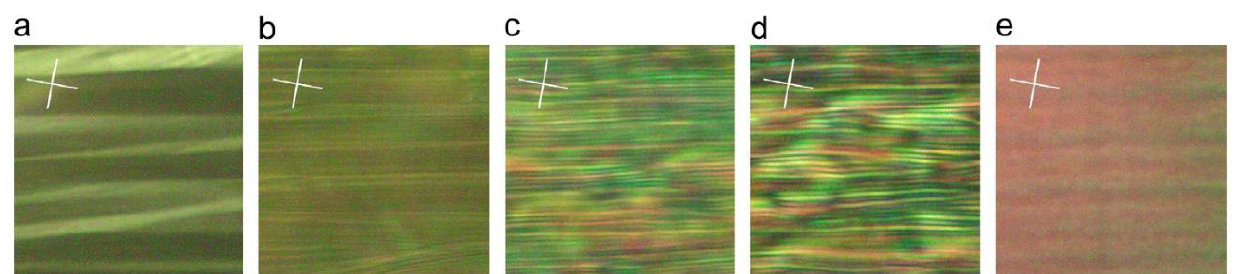
Figure 1. Stripes at the threshold strain of sample, with the final cross-linking done in the isotropic phase, as seen under the crossed polarized microscope. The orientation of crossed polars is indicated and the length of white lines corresponds to 10μm. Initial director orientation was in the vertical direction, and stretching was performed in the horizontal direction. Close to the transition (just below 77.4 °C) a very fine director modulation can be seen. ( a ) T = 70.0 °C, ( b ) T = 75.0 °C, ( c ) T = 77.0 °C, ( d ) T = 77.3 °C, ( e ) T = 77.4 °C [37] (Reprinted with permission from [37]).